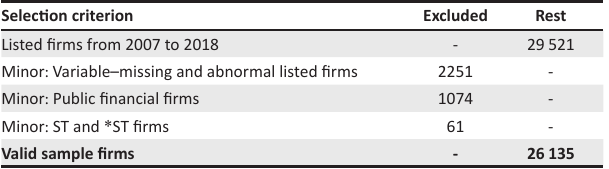
TABLE 2: Sample data selections.